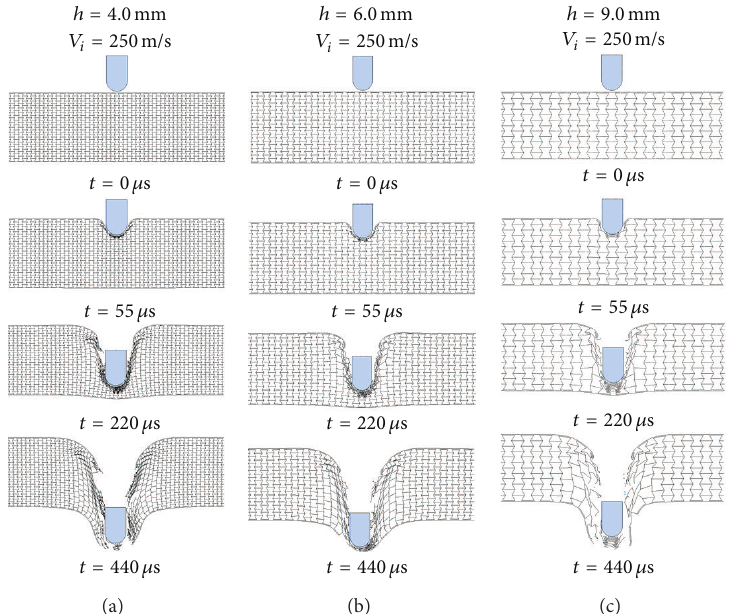
Figure 22: Perforation processes of auxetic HPSs with different reentrant unit cell sizes by projectiles at 𝑉 𝑖 = 250 m/s: (a) ℎ = 4.0 mm, (b) ℎ = 6.0 mm, and (c) ℎ = 9.0 mm.